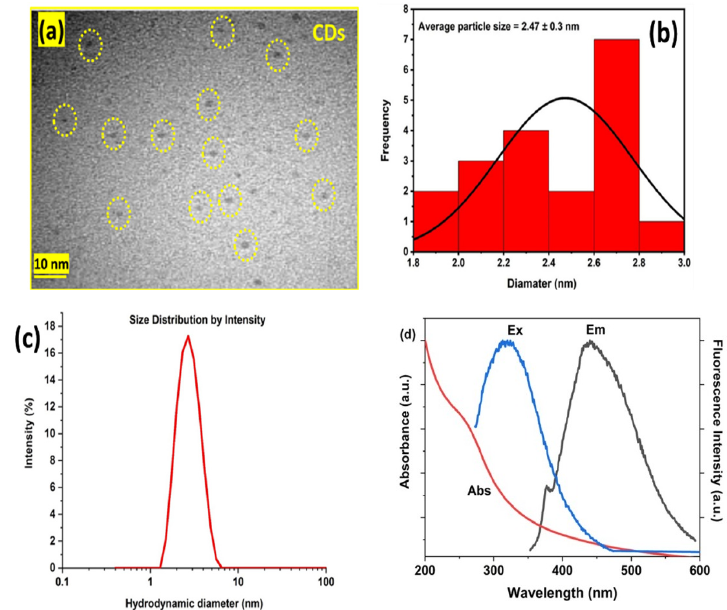
Figure 2. ( a ) TEM image of the CDs; ( b ) particle size distribution histogram of carbon nanodots obtained from TEM micrograph; ( c ) dynamic light-scattering spectrum of carbon nanodots; ( d ) fluorescence spectra and UV/Vis absorption spectrum of the obtained CDs. The emission spectrum was recorded at the excitation wavelength of 320 nm; the excitation spectrum was recorded at the emission wavelength of 440 nm.